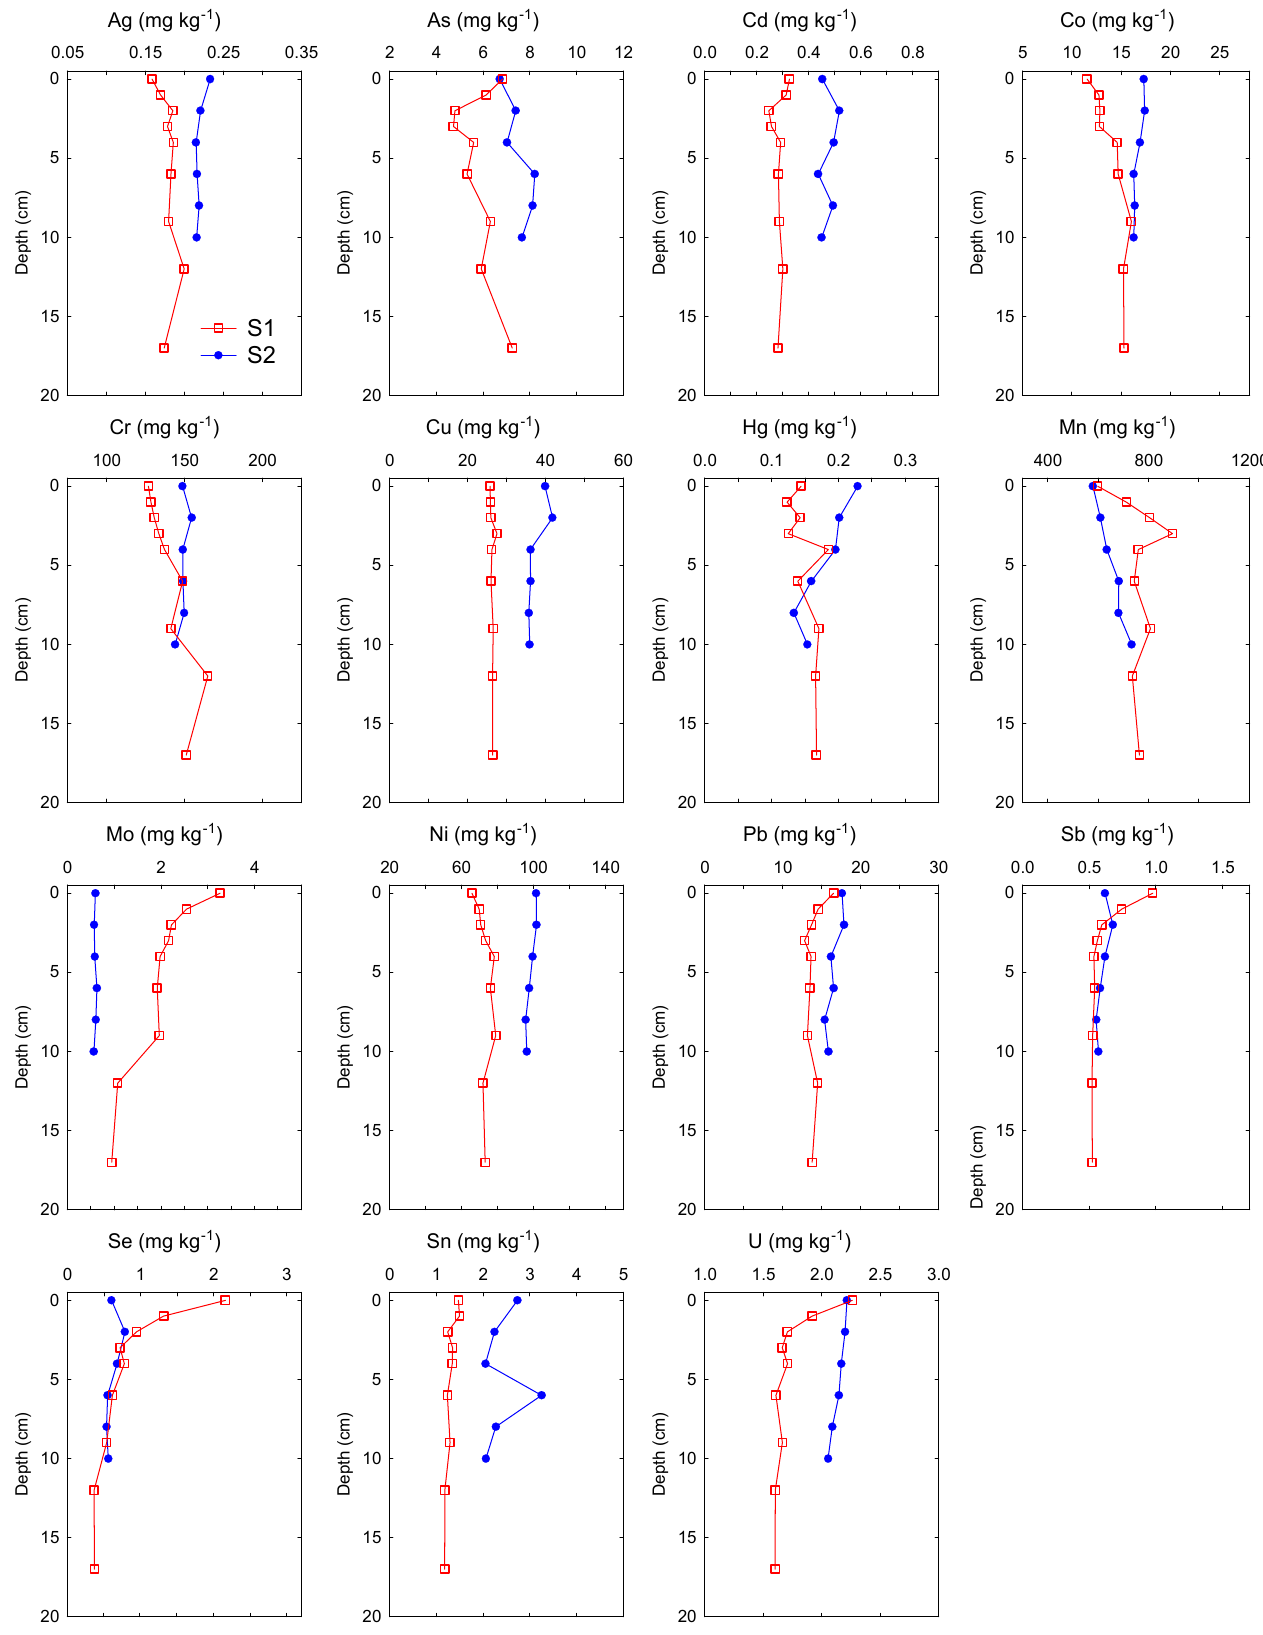
Figure 2. Vertical profiles of major and trace elements in sediment cores from the two locations on the Raša River, collected in June 2020.